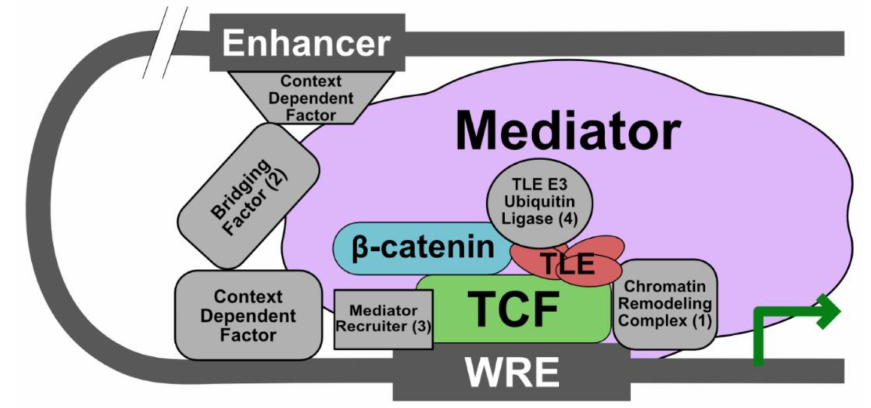
Figure 3. Proposed modified model of a Wnt enhanceosome with a β -catenin-TCF / LEF core complex and other requisite components that are context dependent. We propose that at least four additional components are required to form a functional enhanceosome: (1) a chromatin remodeling complex (e.g., SET-1, a histone methyltransferase, and CBP / p300, a histone acetyltransferase) that promotes gene